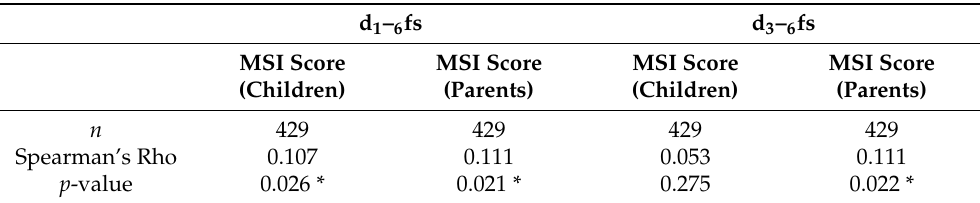
Table 4. Correlations of the MSI scores calculated from the parents and children’s responses with the outcome variables d 1–6 fs and d 3–6 fs from Group